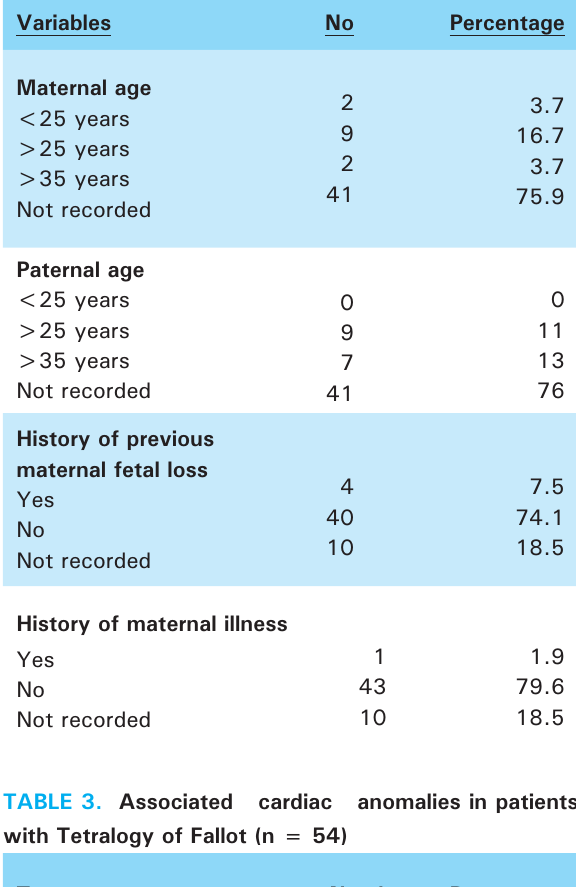
TABLE 3. Associated cardiac anomalies in